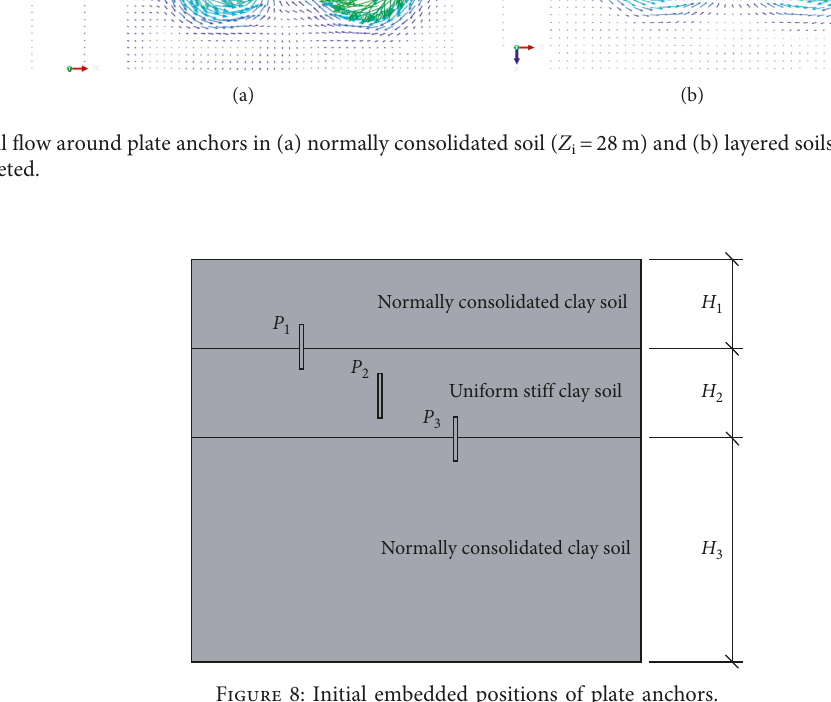
Figure 8: Initial embedded positions of plate